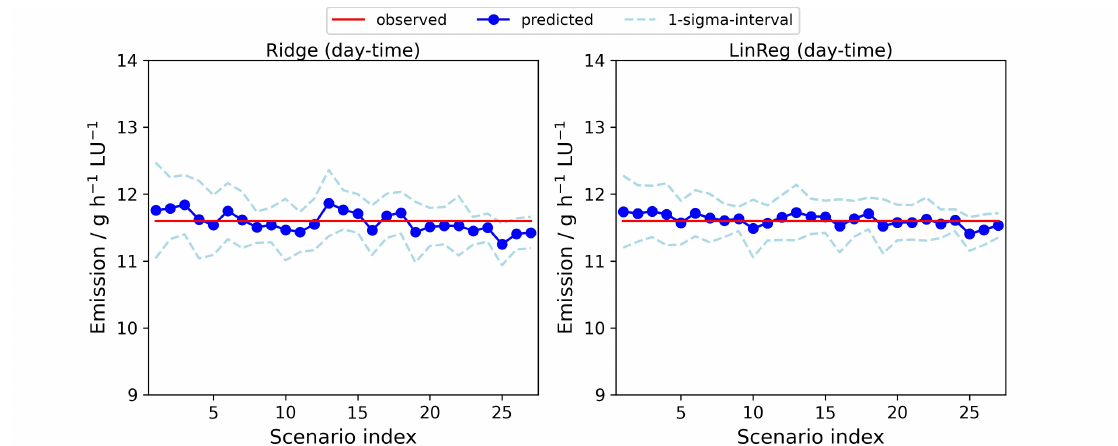
Figure 4. Predictions of methane emissions averaged over the 10 month measuring period with two regression methods and only the sine and cosine transformed day-time as input features. The mean over the predictions based on 30 random realizations of each of the 27 scenarios (as depicted in Figure 1) is marked in blue. The associated one-sigma intervals are indicated by the light blue dashed lines. The red horizontal lines highlight the mean observed emission ( ¯ E n =11.6 g h − 1 LU − 1